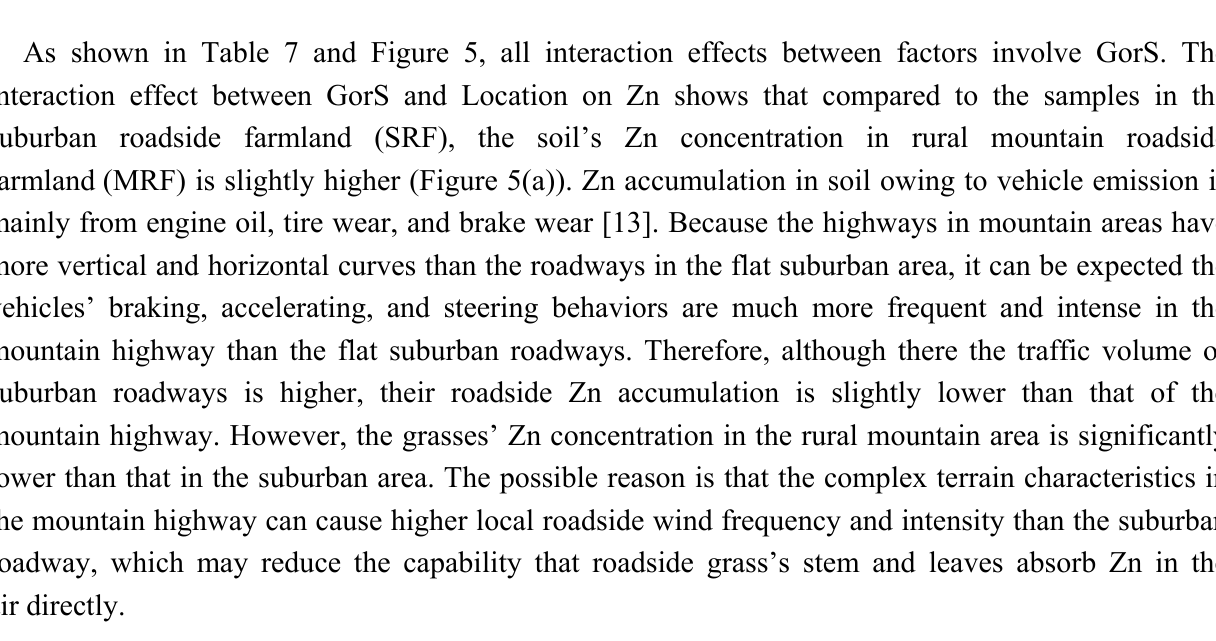
Figure 5. Interaction effects between GorS, location, and tree on heavy-metal